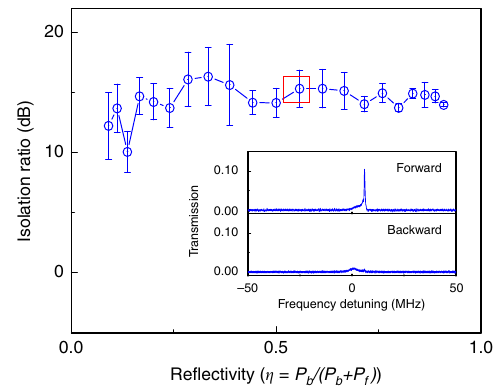
Figure 3 | Optical isolation in terms of reflectivity in the two-fibre- coupling case. The backward input signal power P b is increased from 95.57nW to 9.57 m W. The dropped pump power is maintained at 78 m W. The inset shows the transmission spectra of the marked point with P b ¼ 1.20 m W. The error bars are the standard deviation of the measured optical isolations under the same parameter conditions, whose fluctuations are mainly owing to the backward signal transmission. Other parameters: the fixed forward input signal power is P f ¼ 0.97 m W, k 1 ¼ 2 p (cid:2) 0.29MHz and k 2 ¼ 2 p (cid:2) 0.05MHz.